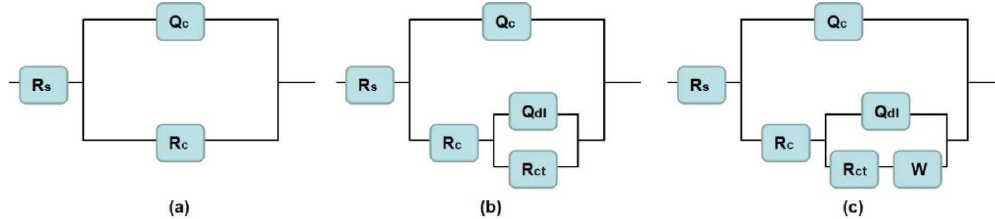
Figure 6. Electrical equivalent circuits used for fitting the EIS spectra. ( a ) one time constants equivalent circuits, ( b , c ) two time constants equivalent circuits.